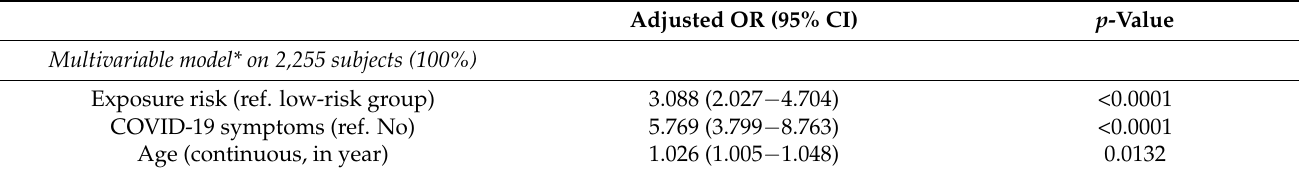
Table 4. Relationship between presence of antibody for SARS-CoV-2 infection (IgG/IgM) and characteristics evaluated during lockdown period. Adjusted OR (95% CI) p -Value Multivariable model* on 2,255 subjects (100%) Exposure risk (ref. low-risk